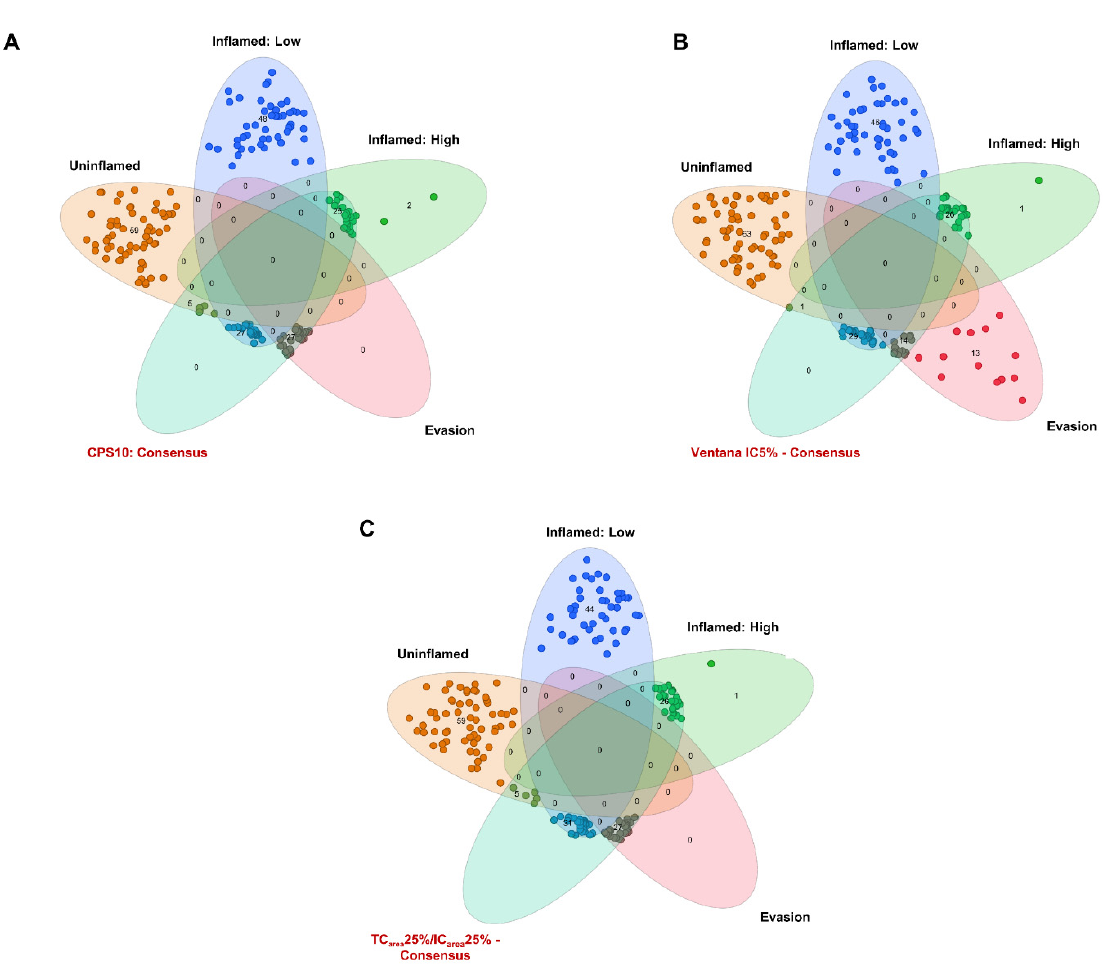
Figure 4. Correlation of PD-L1 scoring algorithms with immune phenotypes. Venn diagrams were constructed to illustrate overlaps of patients classified as positive by the CPS10 ( A ), the Ventana IC5% algorithm ( B ), the TC area 25%/IC area 25% algorithm ( C ) with the four immune biological cluster groups (“Inflamed: High”, “Evasion”, “Inflamed: Low”, “Uninflamed”). Abbreviations: CPS = combined positivity score; IC = immune cell (s); TC = tumor cell (s).